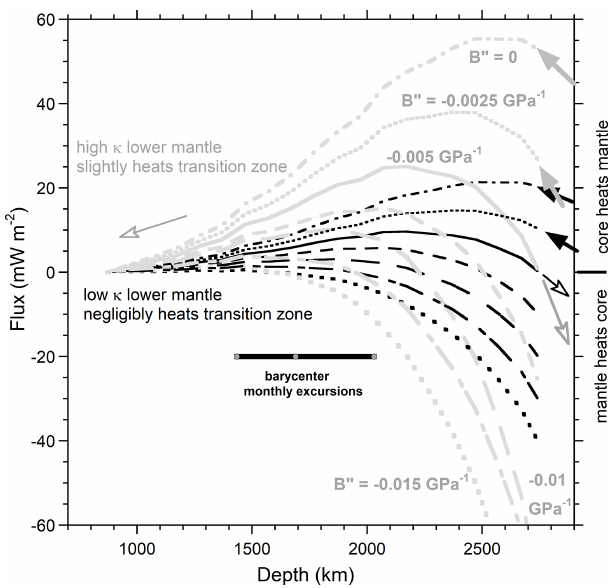
Figure 9. Calculated flux for high oxide and low silicate thermal conductivity, as well as various second P derivatives of the bulk modulus, as labeled. The same patterns are used in Figs. 6 and 8. Arrows are extrapolations across D (cid:48)(cid:48) , showing that most cases indi- cate a heat source in the LM. When flux is positive, the temperature is increasing inwards.